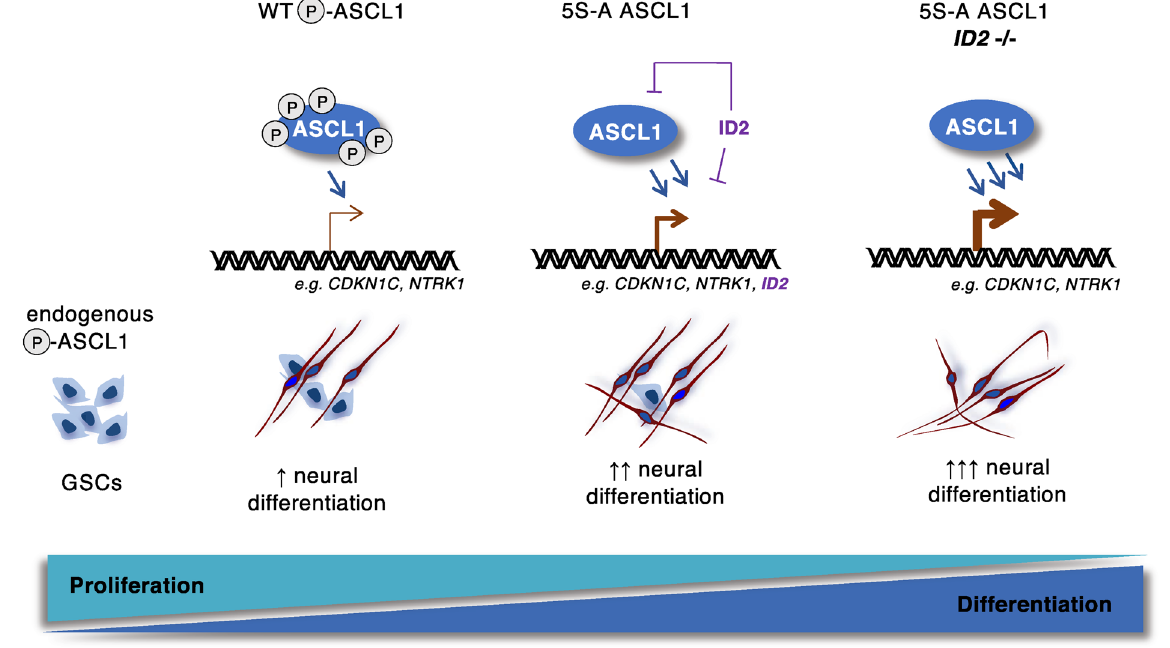
Figure 5. Model showing that ASCL1 dephosphorylation and reduction of ID2 levels can enhance neuronal differentiation of glioblastoma stem